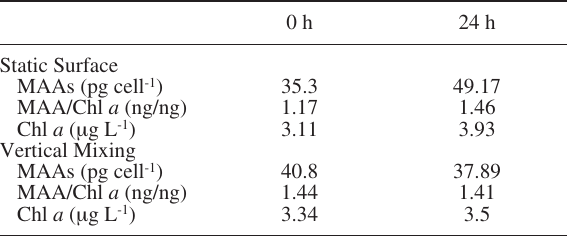
Table 2. – Values of MAA cell contents (pg cell -1 ), MAA/Chl a (ng ng -1 ) ratio and Chl a ( m g L -1 ) in Thalassiosira sp. cultures before the start of the experiments (0 h) and at the end of them (24